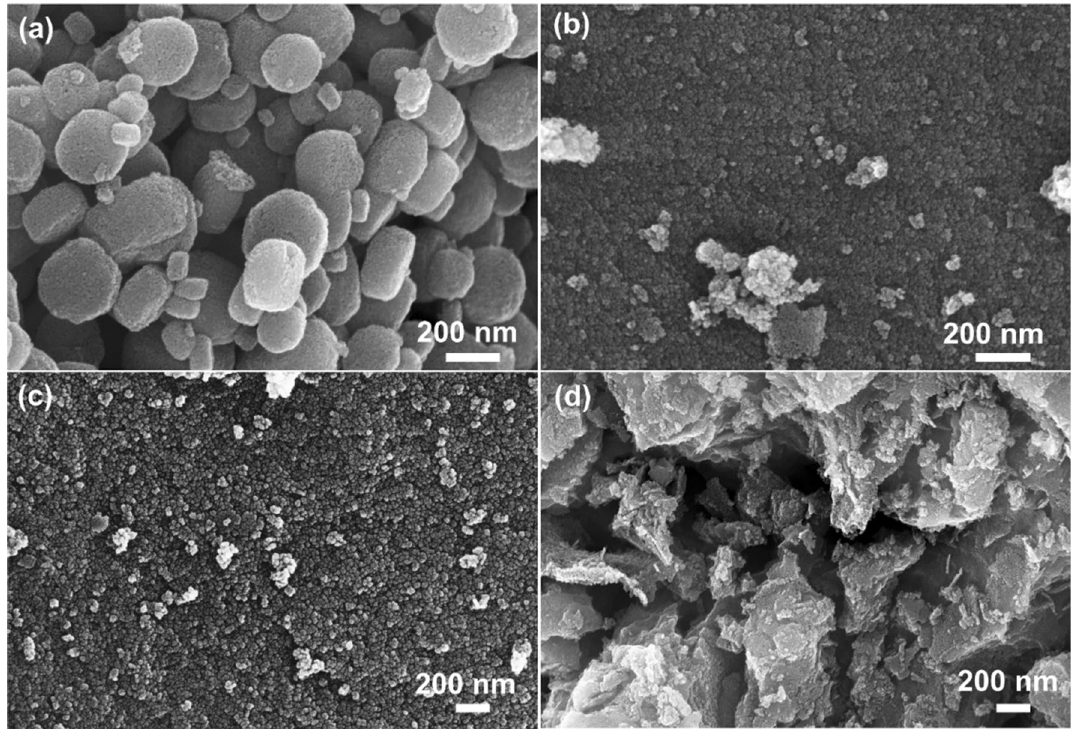
Figure 2. Morphological evolutions of MOF-derived TiO 2 samples from nanodiscs to spherical nanoparticles on